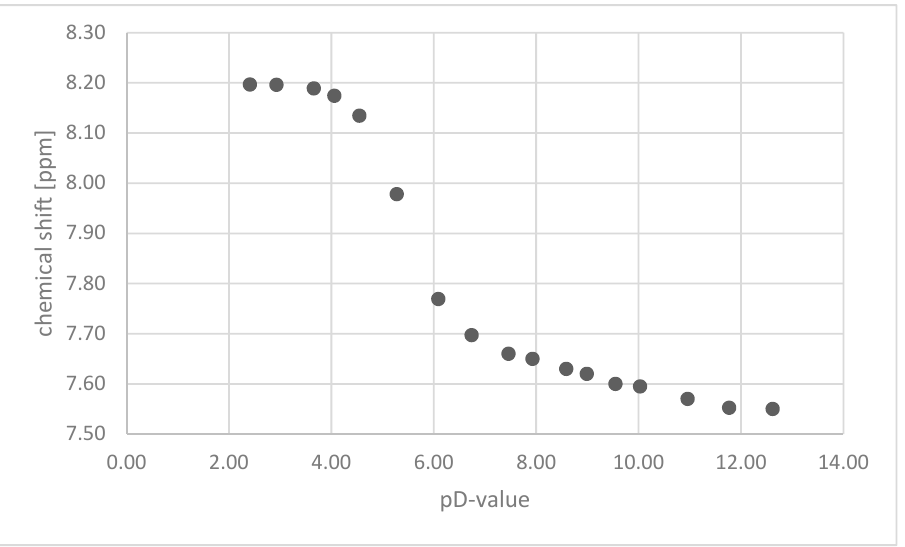
Figure 4. An example plot of the 1 H NMR chemical shift of a ring proton of pyridoxine hydrochloride as a function of pD.